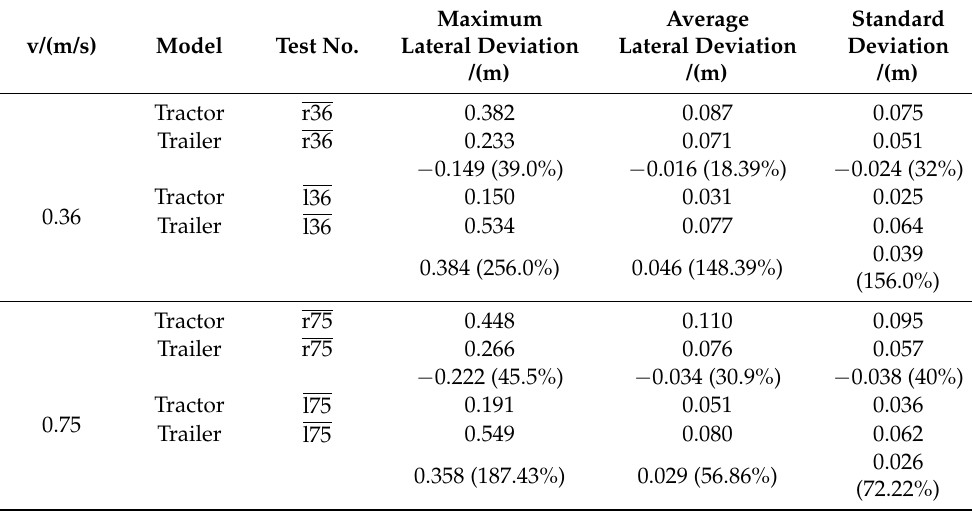
Table 9. Comparison of spraying trailer and tractor path